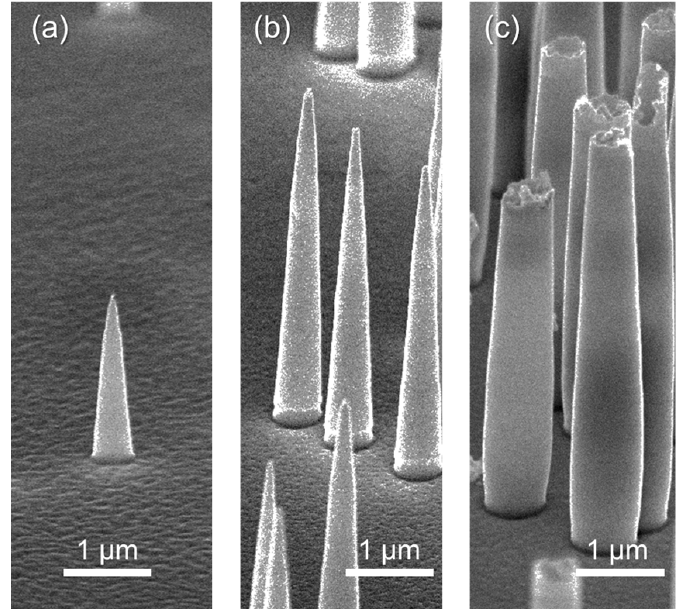
Figure 6. FE-SEM images of the platinum cones. The cones were electrochemically deposited in the conical pores prepared in ( a ) 2.0 ( b ) 4.0, and ( c ) 6.0 mol/dm 3 aqueous NaOH solutions at 60 ◦ C. Figure 7 depicts the EDX spectrum of the platinum cones. The platinum signals were observed at 9.42 keV (L α line), 2.04 keV (M α + M β line) and 1.59 keV (M ξ line). Meanwhile, the other emission lines were assigned to the non-metal components, likely from the elec- trolyte solution PRECIOUSFAB Pt3000, e.g., carbon, nitrogen, oxygen, sulfur, and chlorine. In the electroless deposition method, the other signals of the minor components, such as Sn and Ag, were observed [4]. The platinum cones without any metal contaminations were fabricated by a combination of ion-track etching with the electrodeposition technique.